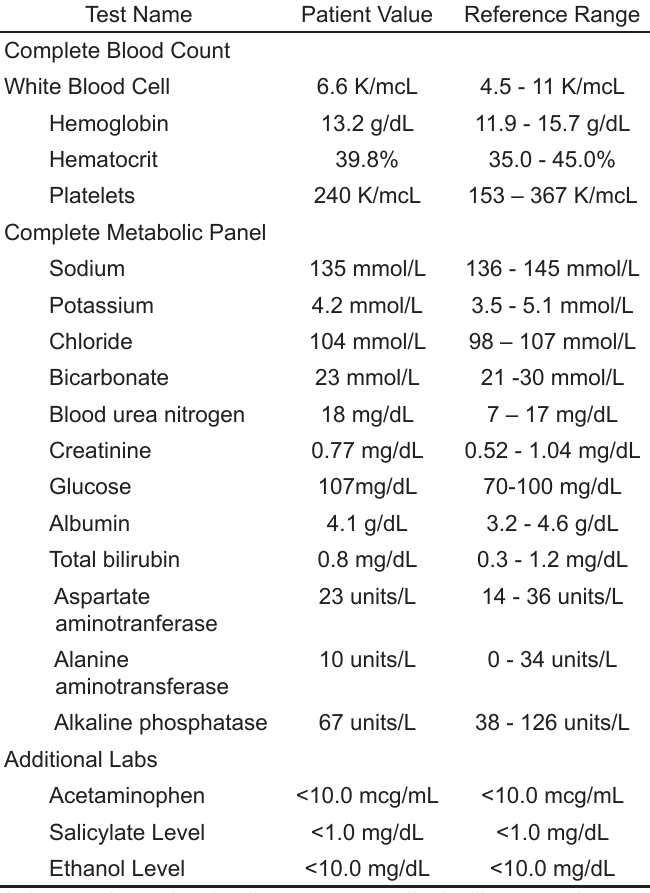
Table 1. Blood laboratory results of a 58-year-old male presenting with a headache, hand numbness, and